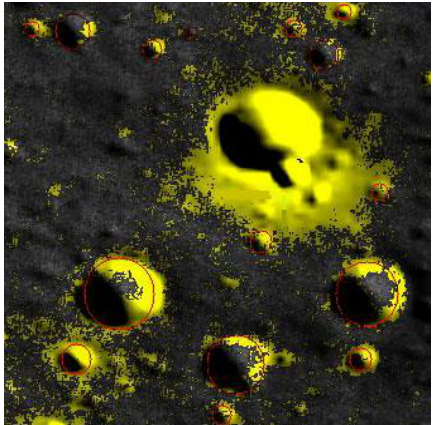
Figure 3. Effect picture of error elimination (N39°-40° ， E323°- 324°, the center wavelength is 1548nm, the spatial resolution is 62m, the yellow area in the picture is defined as regions rich in "non iron" element, and the gray area are regions rich in